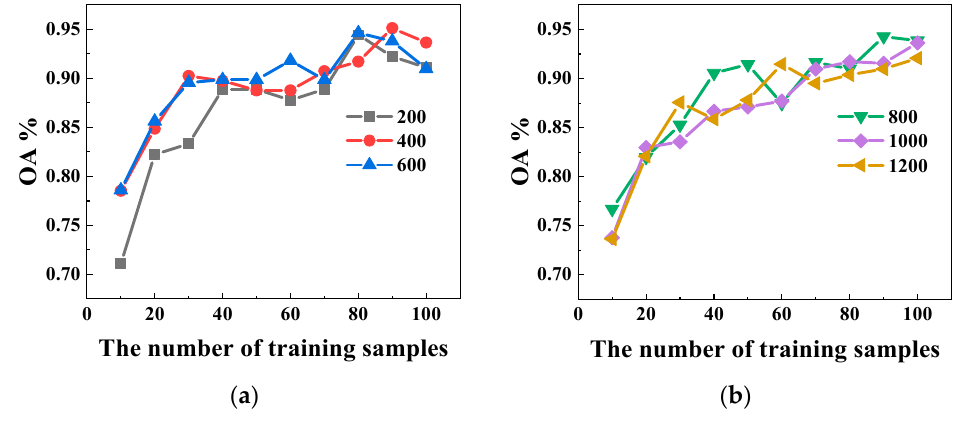
Figure 4. Experimental results with the PaviaU